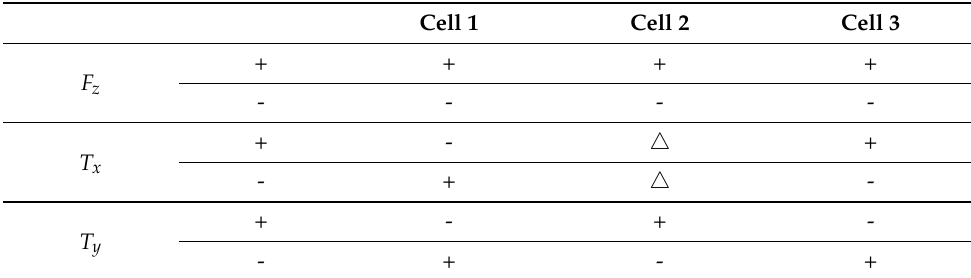
Figure 4. Conceptual view for measuring three-axis force. ( a ) Isometric view of the bolt head and three electrodes. ( b ) Displacement of electrodes when Z-axis force is applied. ( c ) Displacement of electrodes when Y-axis torque is applied. Table 1. Tendency of capacitance change of three cells for the three-axis